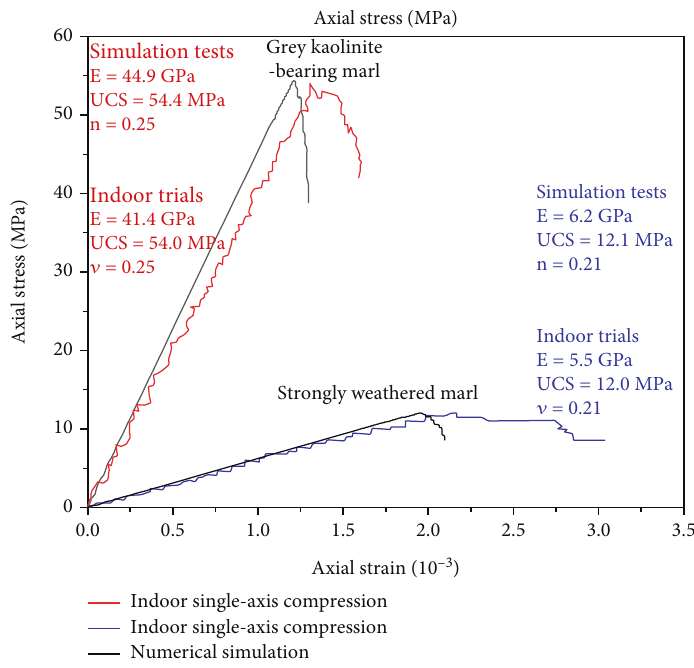
Figure 3: Uniaxial compression test of slip body geotechnical body. Table 1: Table of slide detail